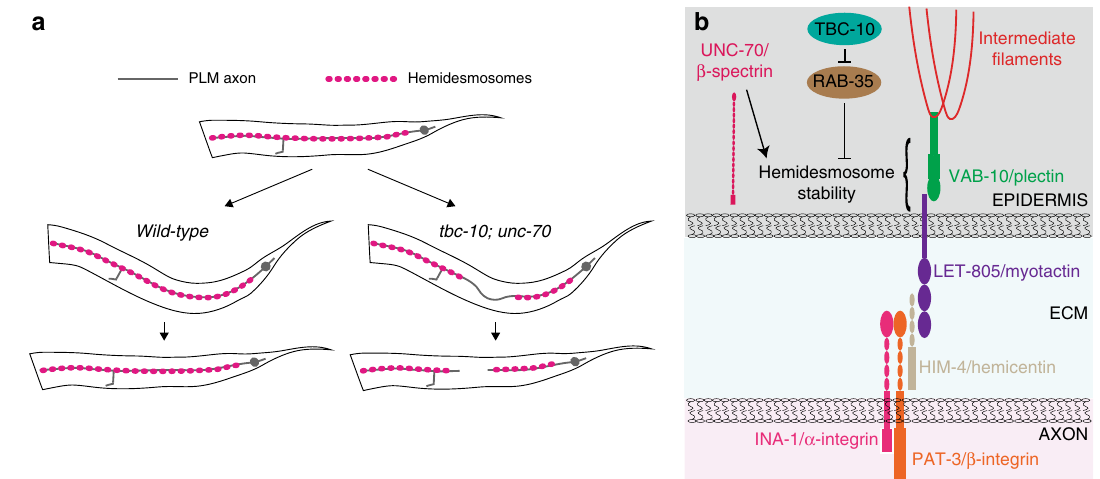
Fig. 7 Proposed model for attachment defects leading to axonal degeneration. a During normal body movement hemidesmosomes are mechanically resistant and attachment is maintained along the length of the axon in wild-type animals. In tbc-10;unc-70 mutants, these attachments are no longer mechanically resistant and the strain of movement leads to the intermittent loss of hemidesmosomes. Successive rounds of movement leads to increased local strain in the now detached axon, causing axonal breakage and degeneration. b Schematic representation of known and proposed components of hemidesmosomes linking the axons of touch receptor neurons to the epidermis. We propose that UNC-70/ β -spectrin, the Rab-GTPase-activating protein TBC-10 and its RAB-35 target, maintain axonal integrity by functioning non-cell autonomously in the epidermis to control the stability of hemidesmosomes in response to mechanical strain via parallel